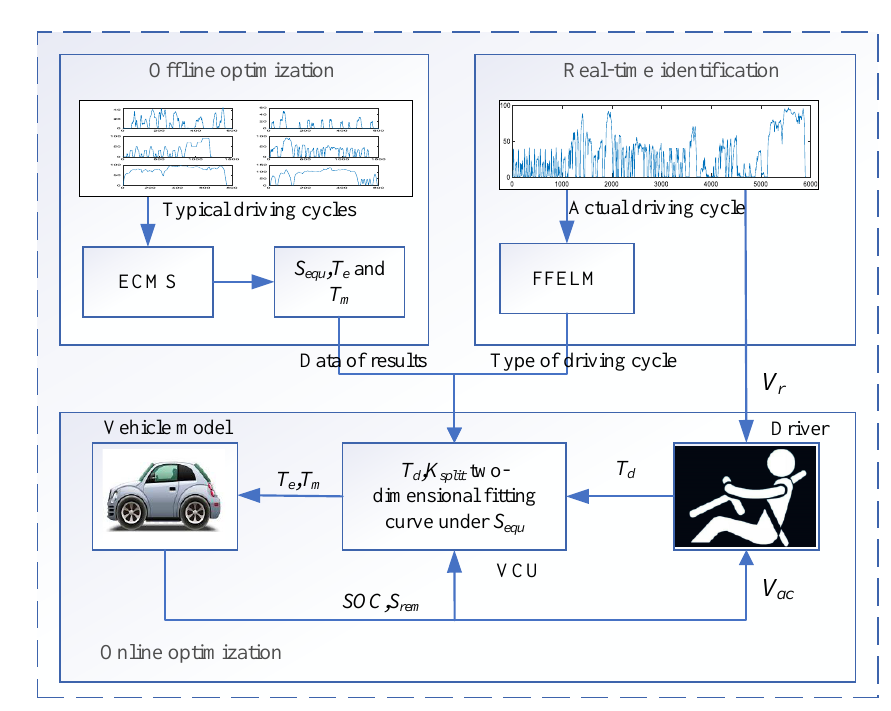
Figure 8. The structure of the proposed